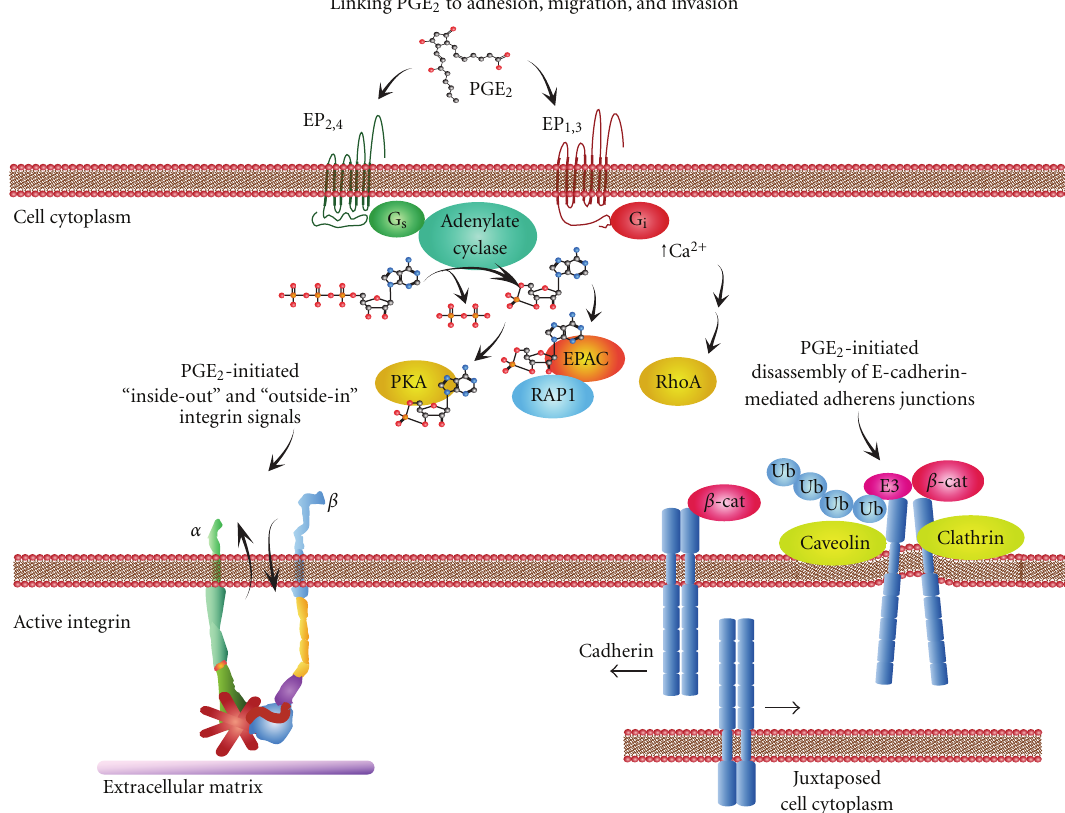
Figure 6: Linking PGE 2 to adhesion, migration, and invasion. Prostaglandin E 2 elicits profound changes in tumor cells that result in the disassociation of cadherin-mediated cell connections. This is accompanied by the establishment/turnover of integrin-mediated interactions with extracellular matrix during adhesion and subsequent migration and invasion. Stimulation of EP2 or 4 receptors leads to the activation of adenylate cyclase and results in the production of cyclic adenosine monophosphate (cAMP) from adenosine triphosphate (ATP). The accumulation of cAMP in the cell cytoplasm activates protein kinase A (PKA) and the phosphorylation of downstream targets. This accumulation of cAMP can also activate exchange protein activated by cAMP (Epac). The activation of Epac may involve the interactions with Rap1 and subsequent downstream signals that influence adhesion, migration, and invasion. The activation of EP1 and EP3 leads to Ca 2+ influx and the activation of Rho-mediated signal transduction that influences cadherin function during the disassociation of cadherin-based adhesive contacts or integrin interactions with the extracellular matrix